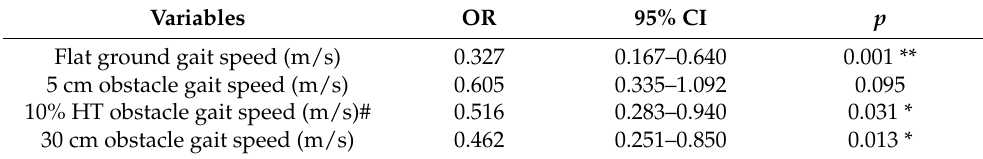
Table 6. The relative risk for different gait speeds in each condition, according to fall risk level (BBS). Variables OR 95% CI p Flat ground gait speed (m/s) 0.327 0.167–0.640 0.001 ** 5 cm obstacle gait speed (m/s) 0.605 0.335–1.092 0.095 0.516 0.283–0.940 0.031